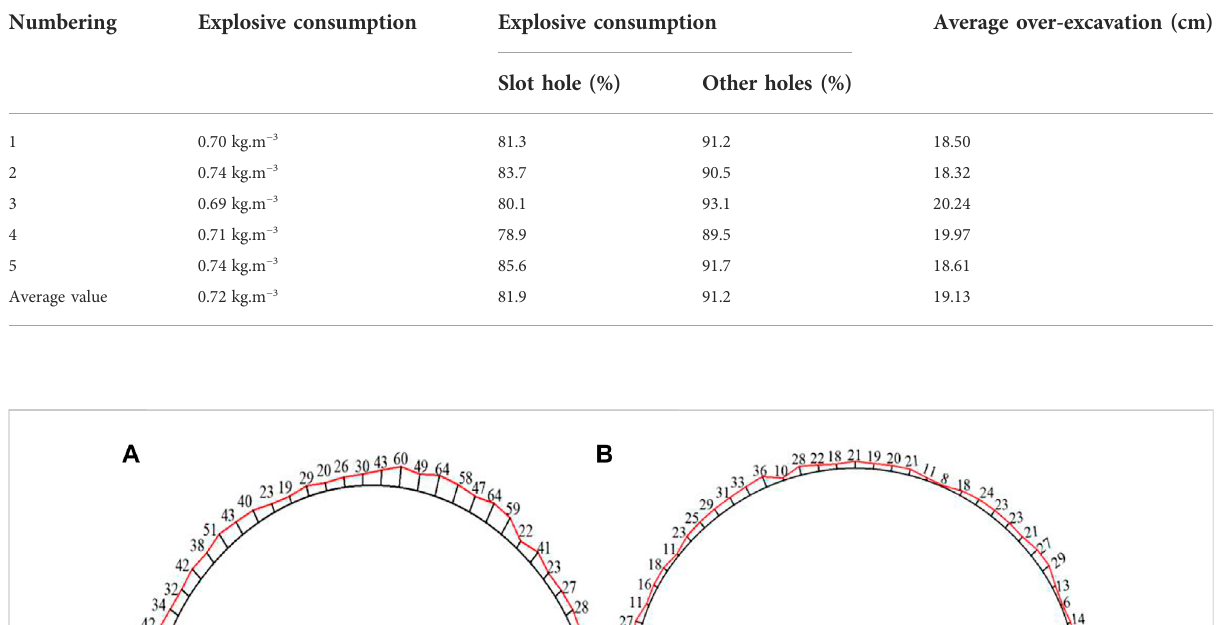
TABLE 7 Data after the on-site test.